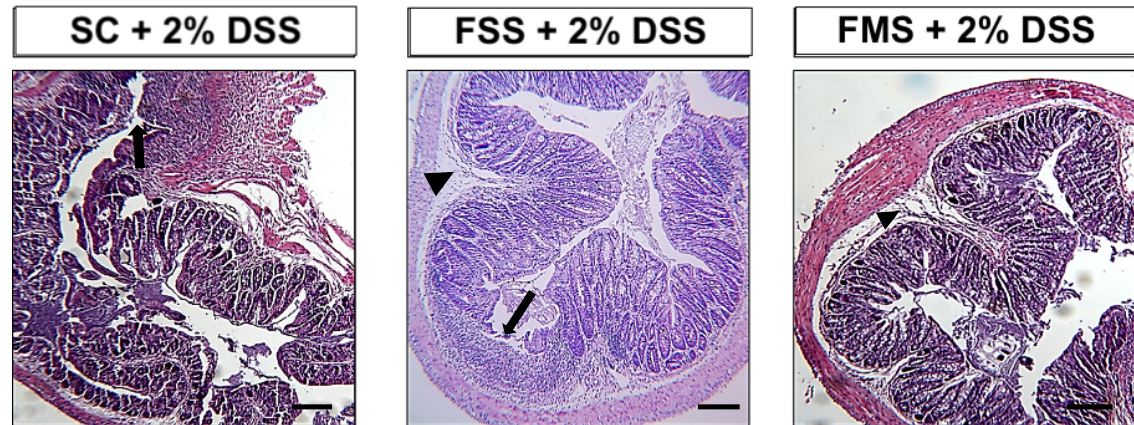
Figure 2. Representative haematoxylin- and eosin-stained sections of the distal colon from mice treated with 2% w/v dextran sodium sulphate for 5 days followed by another 5 days on plain drinking water. Arrowheads highlight submucosal oedema; arrows highlight almost complete loss of colonic epithelium. Scale Bar: 200 µm